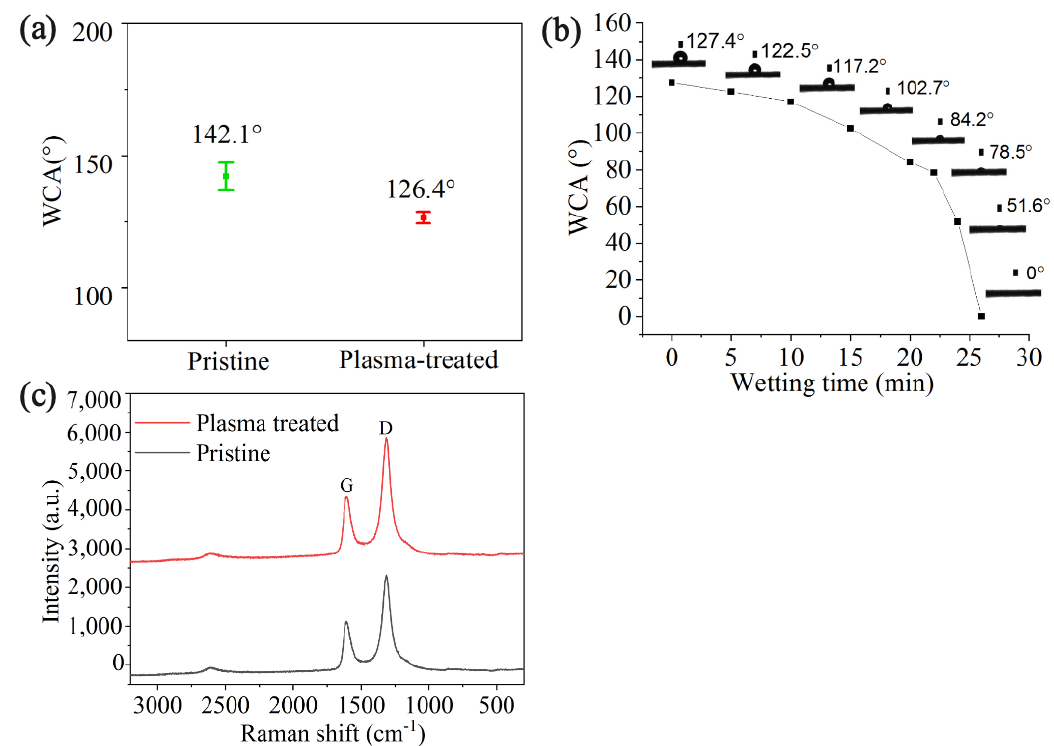
Figure 1. ( a ) The mean contact angle of carbon fabric before (in green) and after plasma treatment (in red); ( b ) A set of water contact angles (WCA) changes on plasma-treated carbon fabrics as a function of wetting time: 0, 5, 10, 15, 20, 22, 24, and 26 min; and, ( c ) Raman spectra of pristine carbon fabric and plasma treated carbon